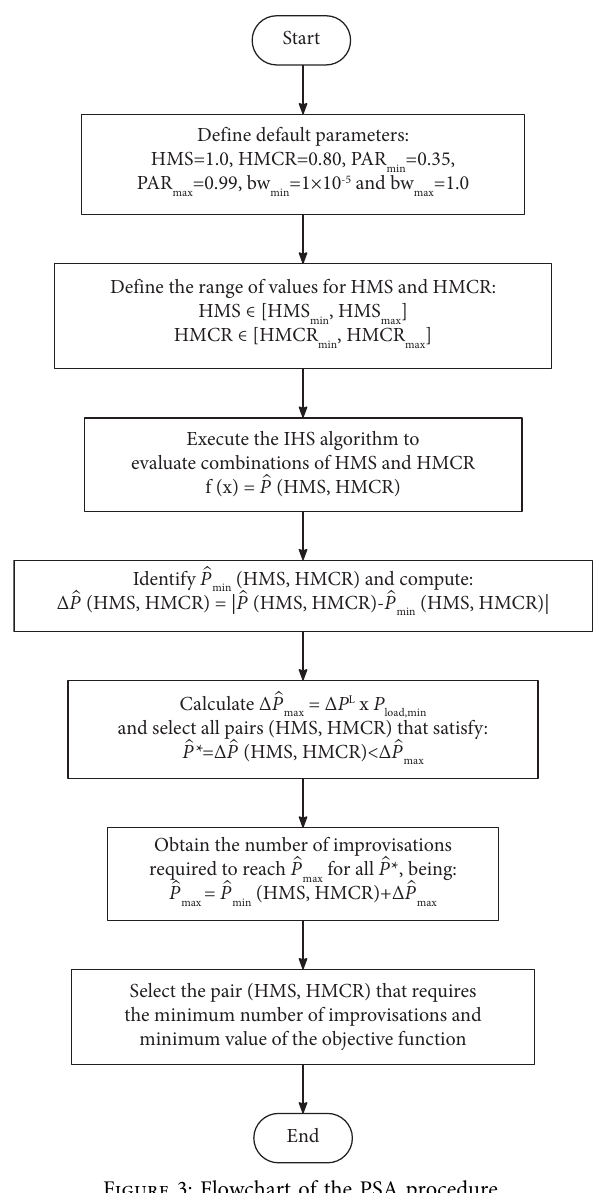
Figure 3: Flowchart of the PSA